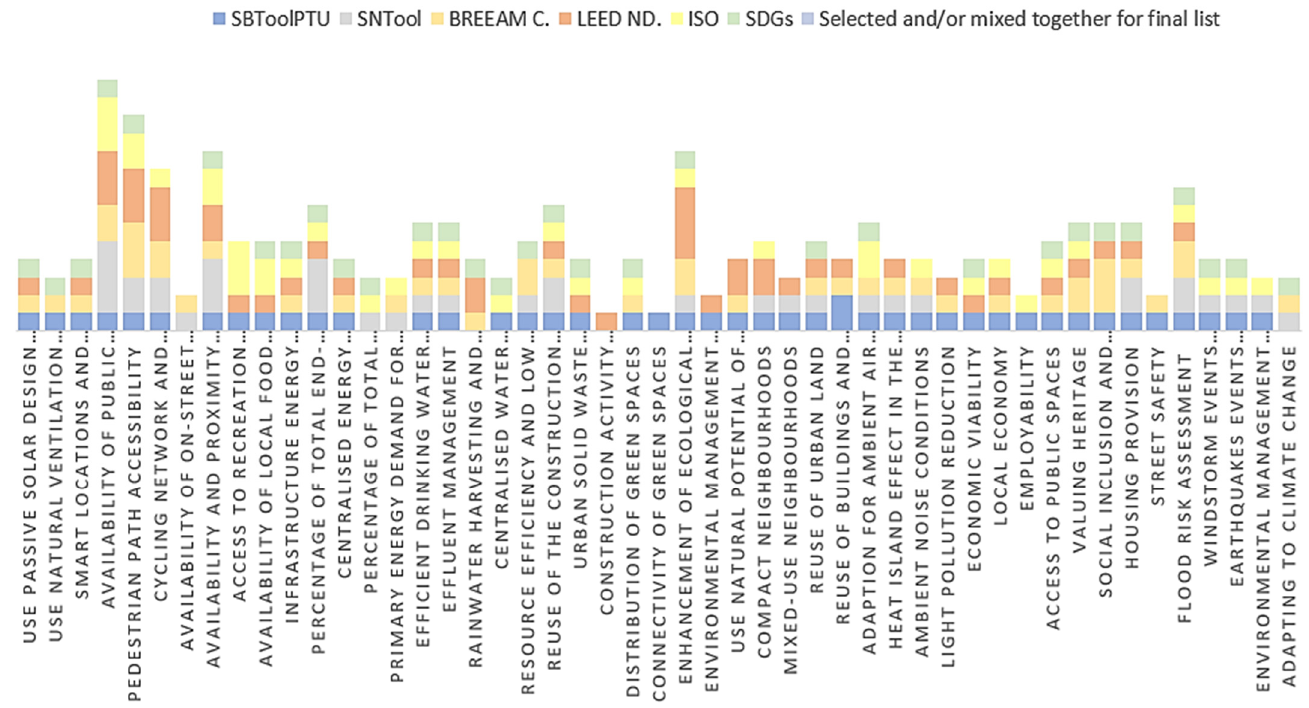
Figure 13. Frequency distribution of each indicator, in SBTool PT _Urban (2018), SNTool Min (2020), BREEAM-C (2012), LEED-ND (2018), ISO 37120, and SDGs.